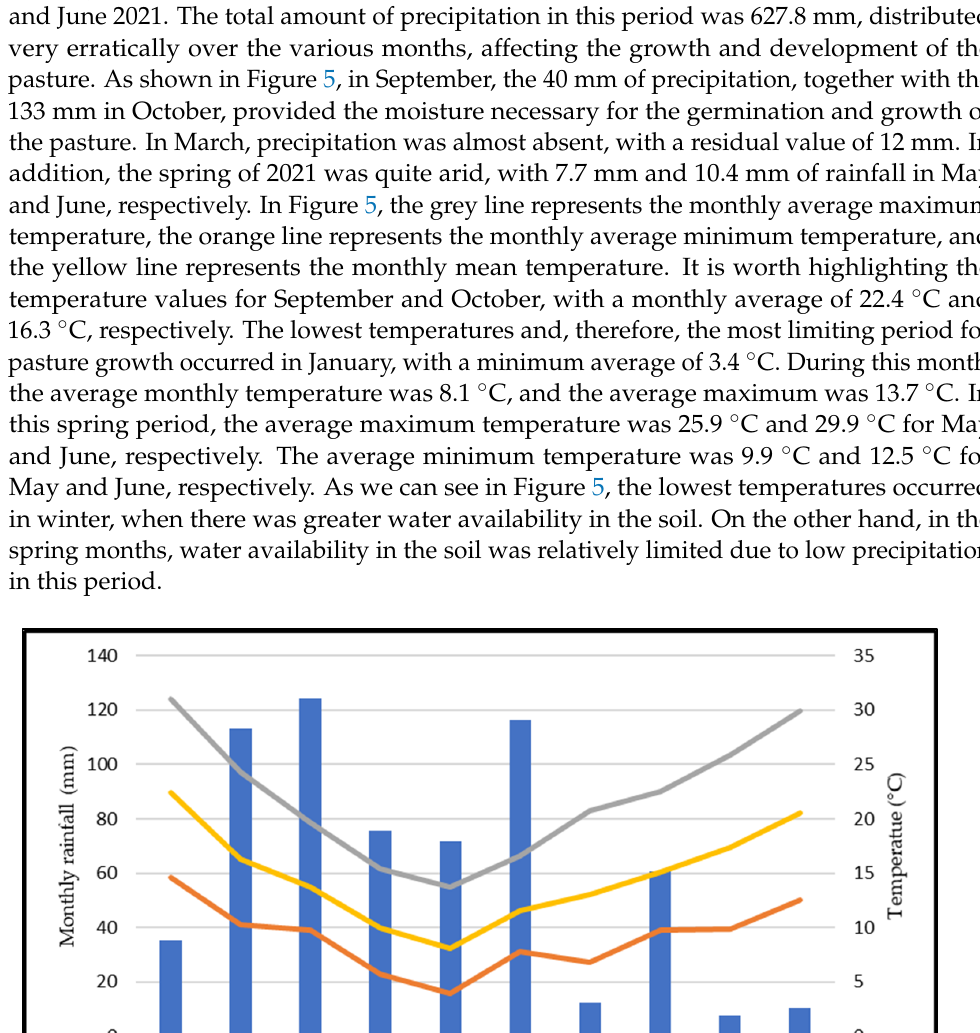
Figure 6. Number of grazing days in each treatment, per month.